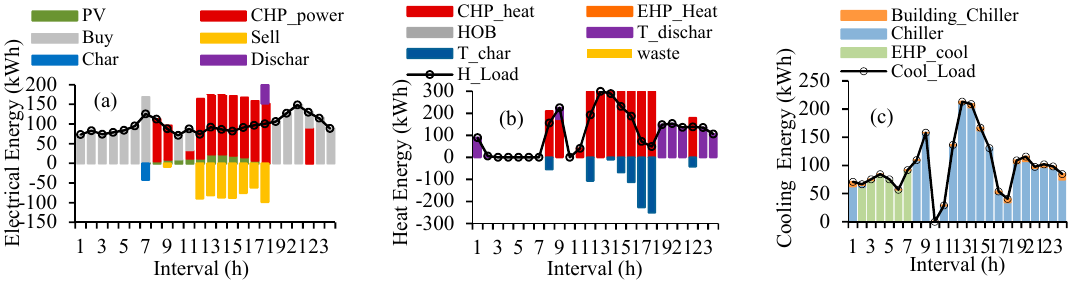
Figure 10. Energy balance in summer season: ( a ) power; ( b ) heat energy; and ( c ) cooling energy.